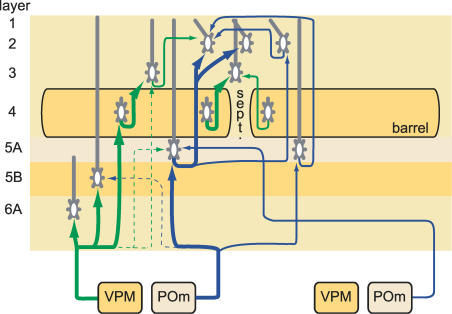
Circuit diagram of the thalamocortical and ascending intracortical projections in the barrel cortex. (Lemniscal projections, green; paralemniscal projections, blue.) Thick, thin, and dashed lines denote decreasing density of the projection.